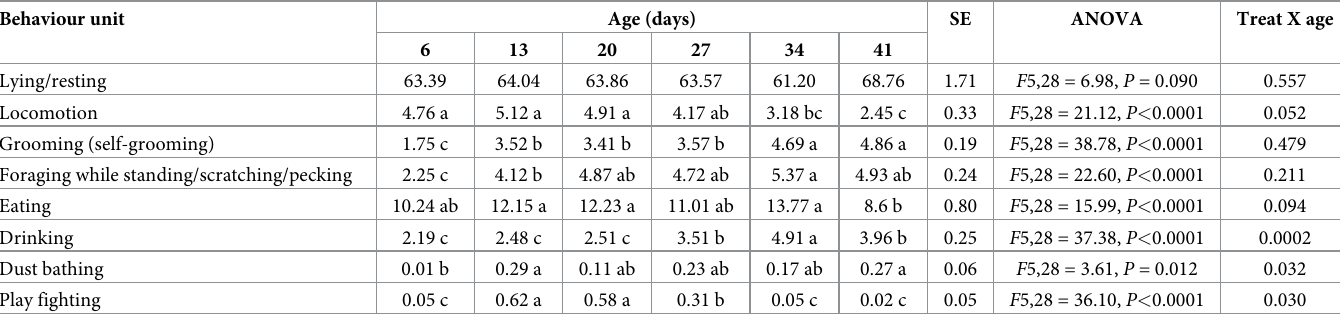
Table 3. Frequency (%) of each behaviour observed for broiler chickens as effects of age. Behaviour